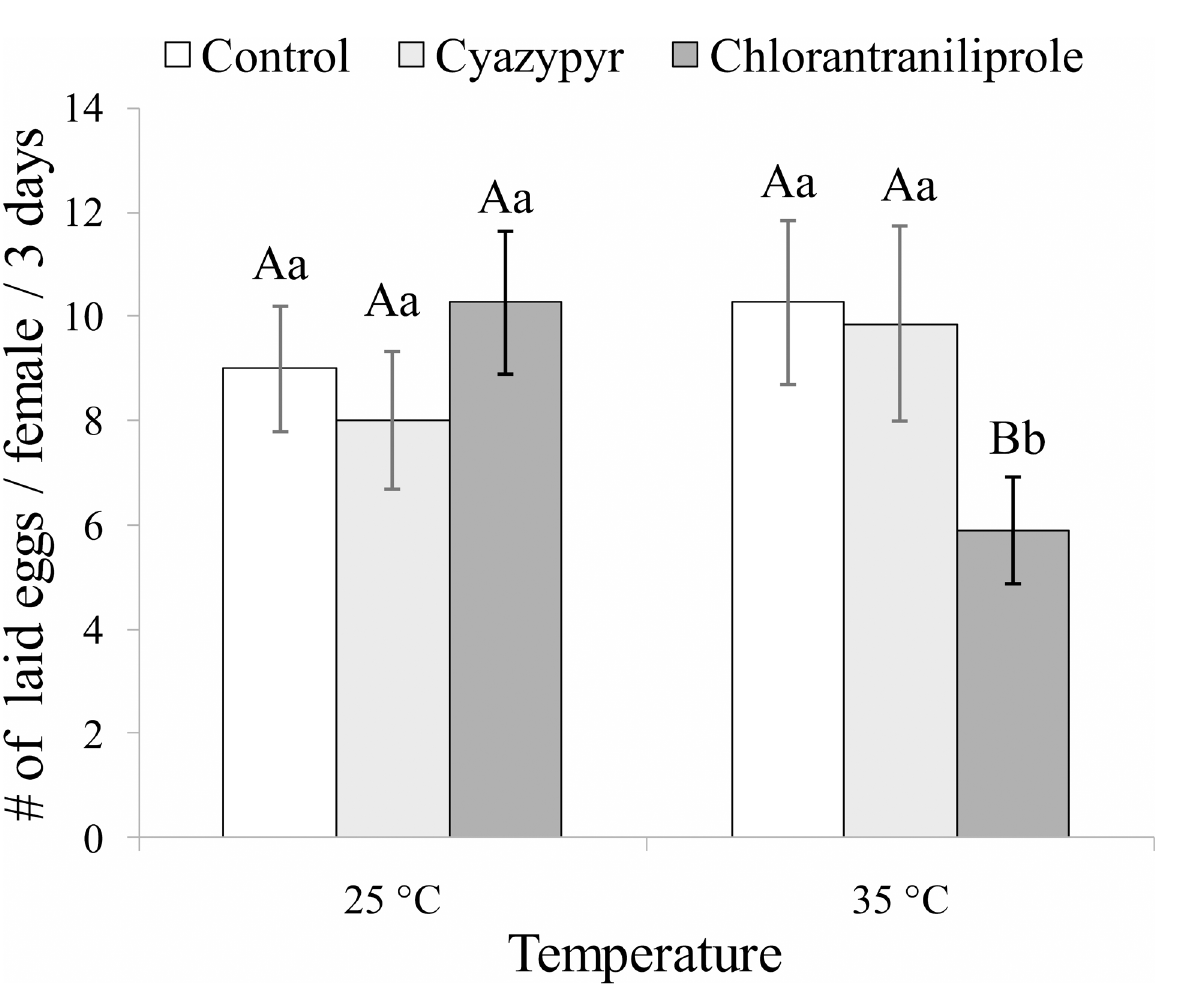
Fig 2. Sublethal effects on reproduction. Means ( ± SEM) of number of eggs laid in three days by each tested Bracon nigricans female previously exposed for three days to residues at three constant temperatures. Columns bearing the same letter (upper case letters: within the same temperature regime; lower case letters: within the same tested insecticide) are not significantly different ( P > 0.05; ANOVA with LSD post hoc test for multiple comparisons).